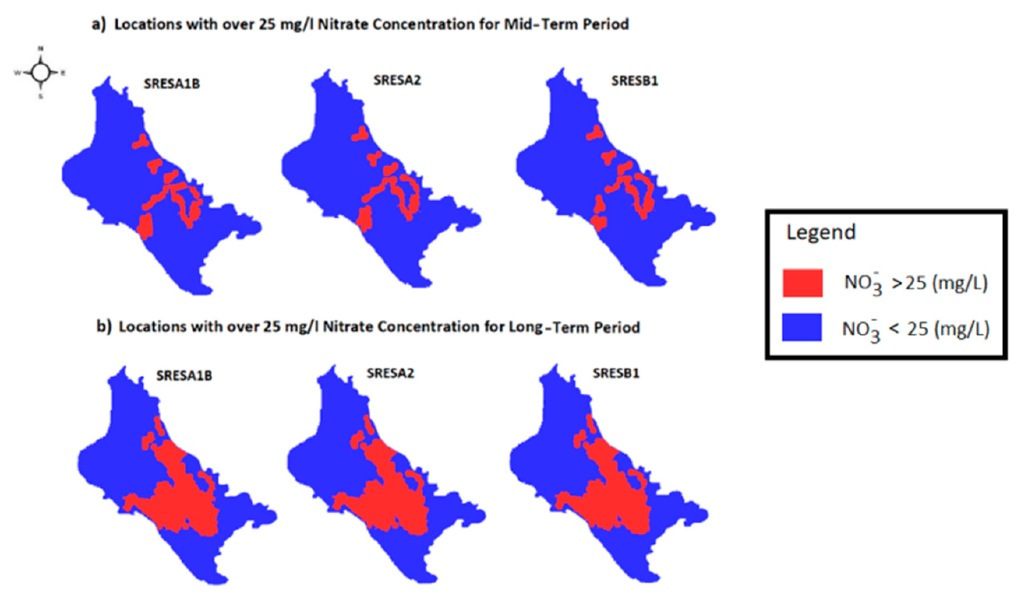
Figure 10. Spatial distribution of 25 mg / L excess for all three socio-economic scenarios for the historical period of no-reservoir scenario: ( a ) For Mid-Term Period of 2030–2050 and ( b ) for Long-Term Period of 2080–2100.